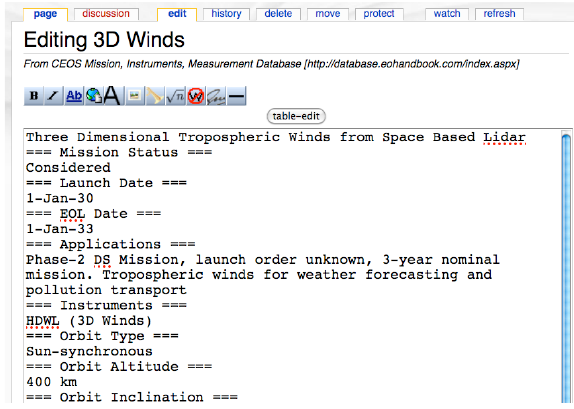
Figure 1. Semantic MediaWiki editing interface